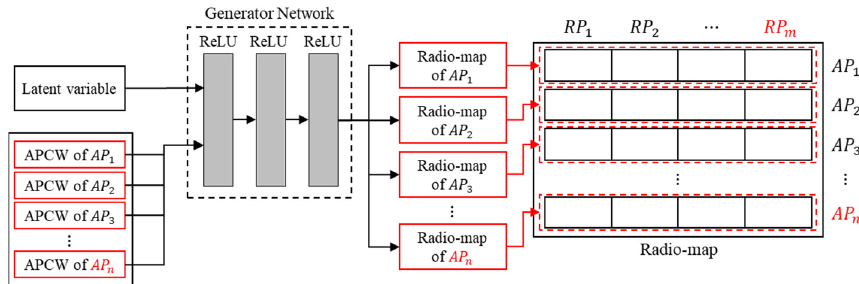
Figure 8. Radio-map construction process in the generation phase.